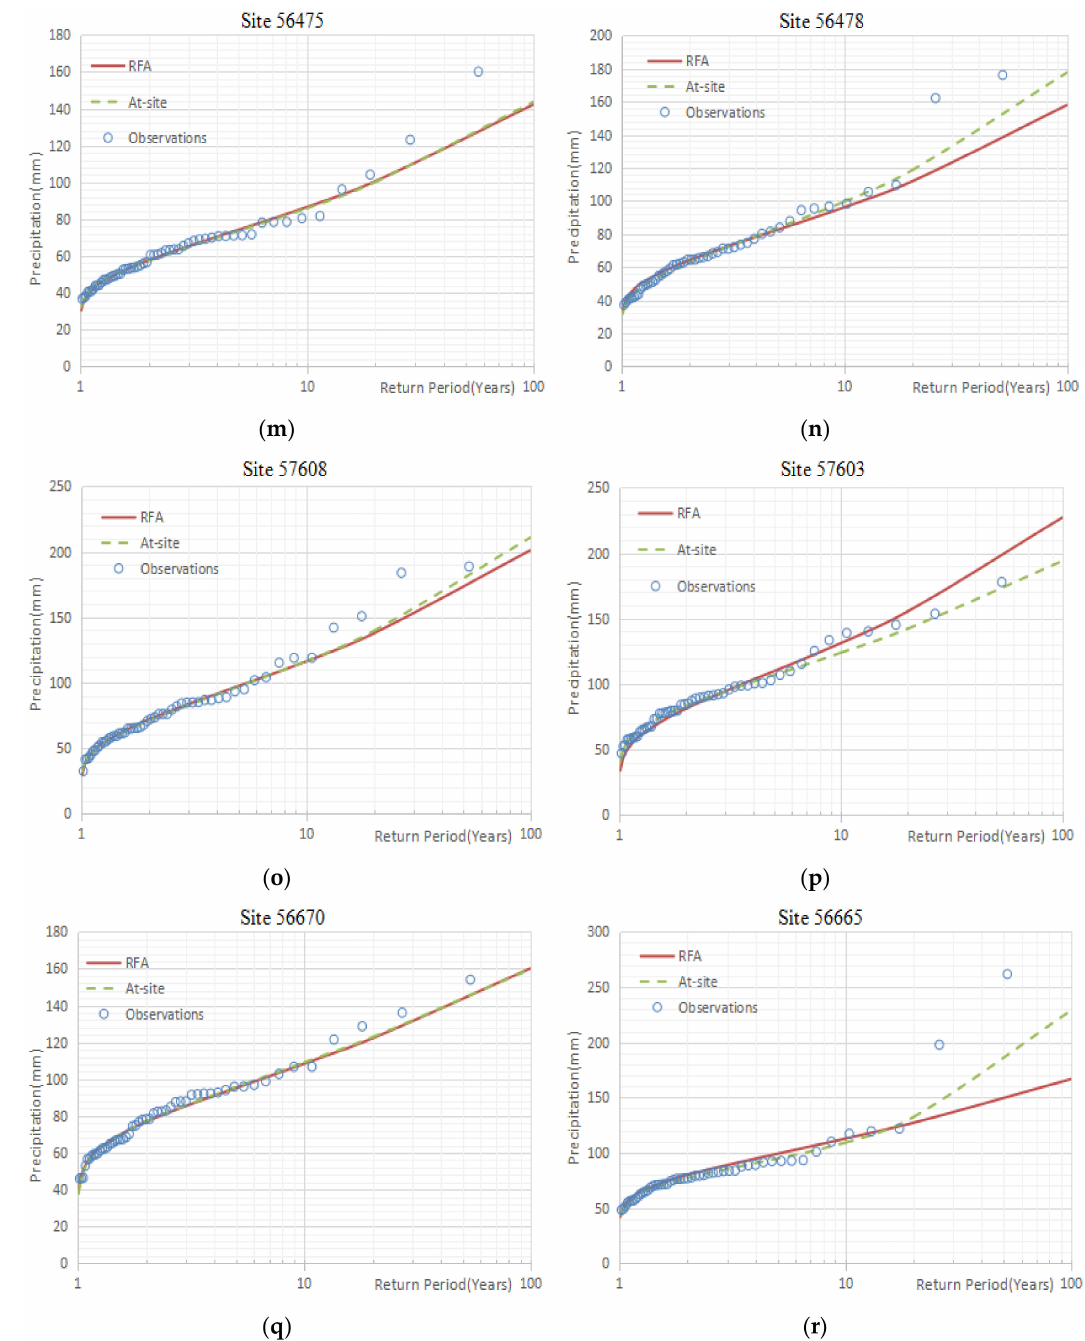
Figure 2. ( a – r ) are the results of the design frequency curves obtained by the two methods fitted to observed data for 18 representative stations. RFA: regional frequency analysis; At-site: traditional at-site hydrological frequency analysis; Observations: observed annual maximum daily precipitation data